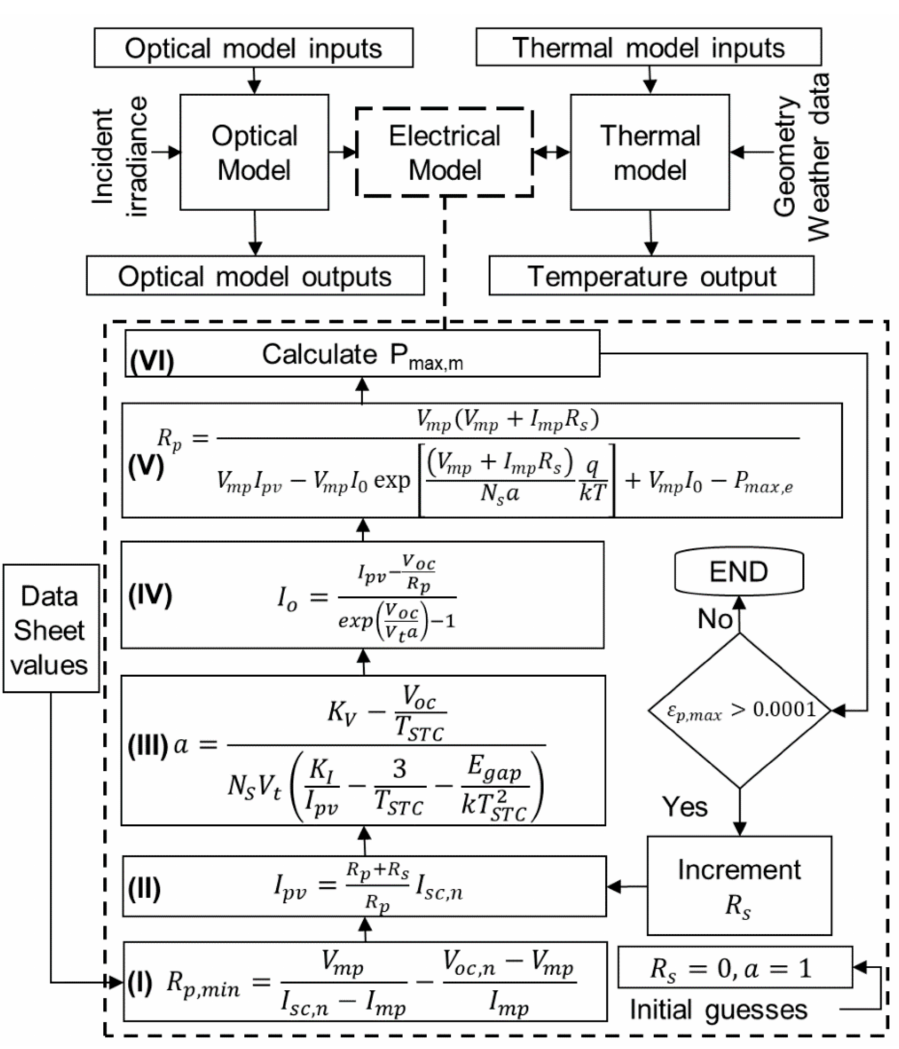
Figure 4. Flowchart of the fully coupled optical-thermal-electrical simulation model, with details of the electrical